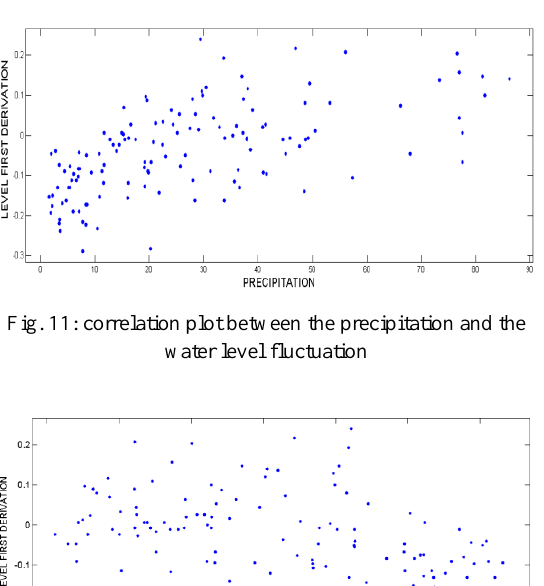
Fig.12: correlation plot between the temperature and the water level